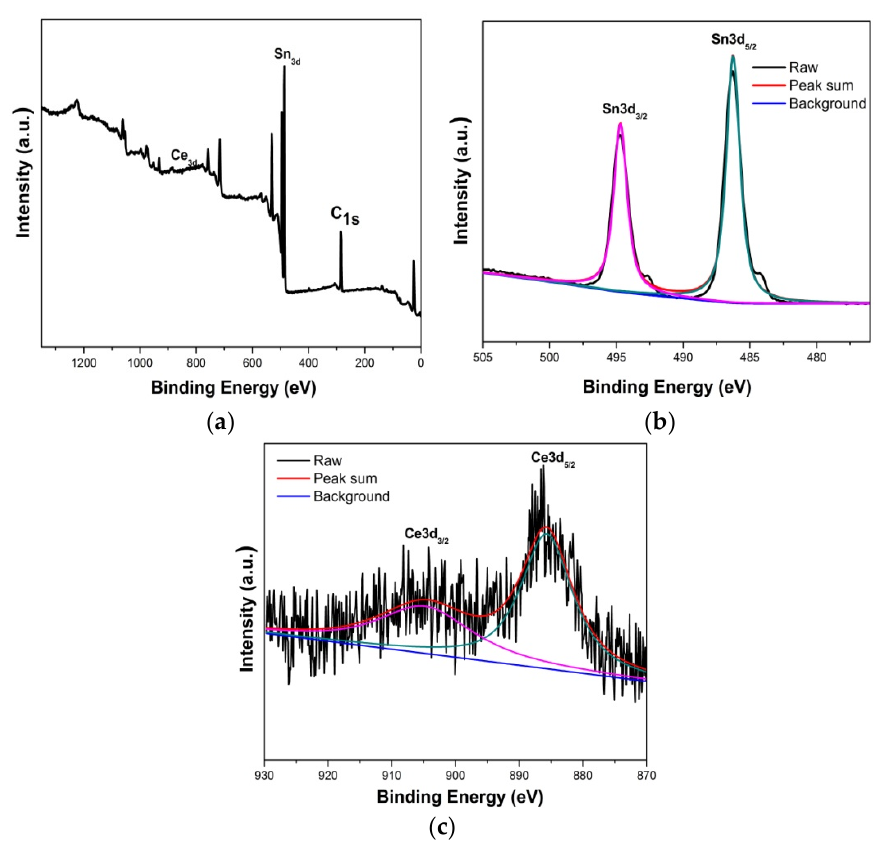
Figure 7. XPS spectra: tin plating. ( a ) Total peak figure, ( b ) Satellite peak of tin, ( c ) Satellite peak of cerium.